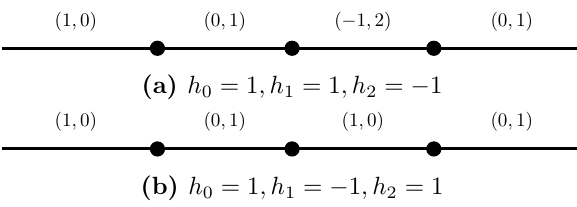
Figure 2. Inequivalent rod structures for 3-centred